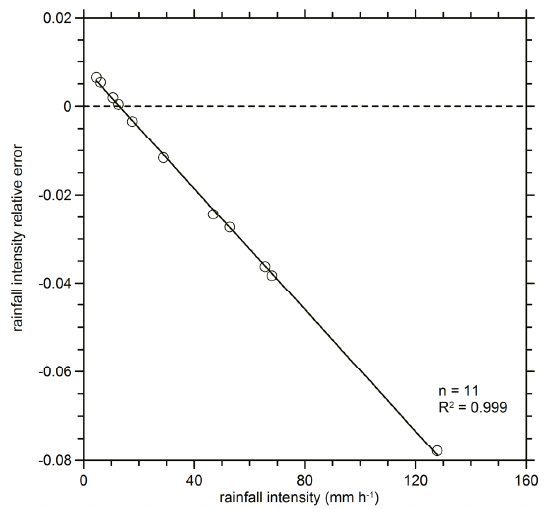
Figure 2. Fig. 2. Relative errors in the determination of rainfall depth (and intensity) when a fixed volume of the rain recorder tipping bucket is